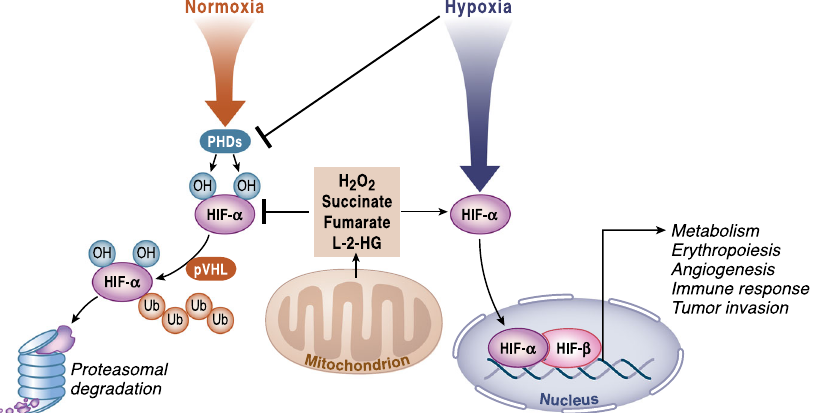
Fig. 5 TCA cycle metabolites regulate HIF- α stabilization. Under normoxia, HIF- α is hydroxylated by prolyl-hydroxylases (PHDs) and targeted for proteasomal degradation by von Hippel-Lindau (pVHL) complex. Under hypoxic conditions, PHDs activity is inhibited preventing HIF- α hydroxylation, which causes its stabilization. HIF- α then translocates to the nucleus where it associates with HIF-1 β to activate transcription of HIF target genes involved in metabolism, angiogenesis, erythropoiesis, immune responses, and tumor invasion. In normoxia, ROS released from mitochondria and accumulated levels of the metabolites succinate, fumarate and L-2-HG can inhibit the activity of PHDs causing a pseudohypoxia state.